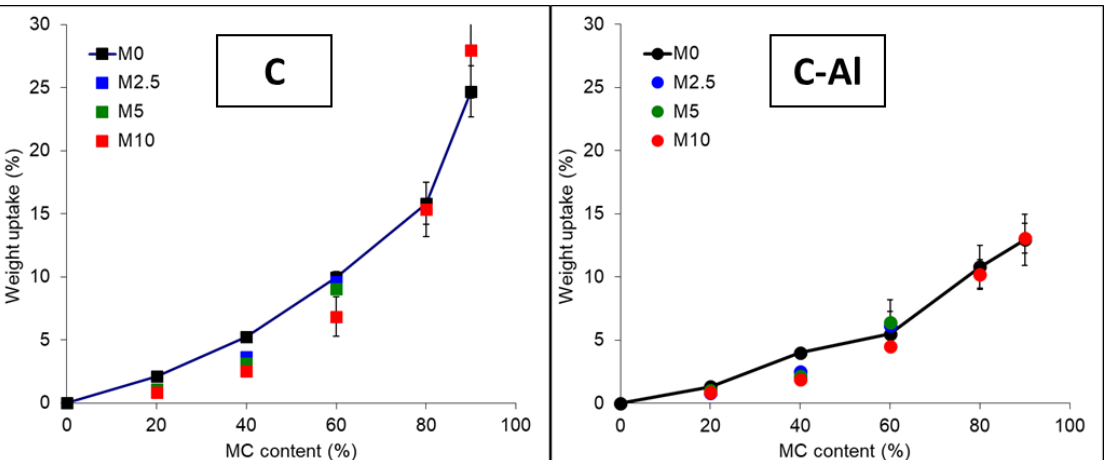
Figure 5. Water absorption after 1000 h of water immersion for the prepared composites. Lines connecting points of the M0Cx-CAlx systems are reported as a guide for the eye.